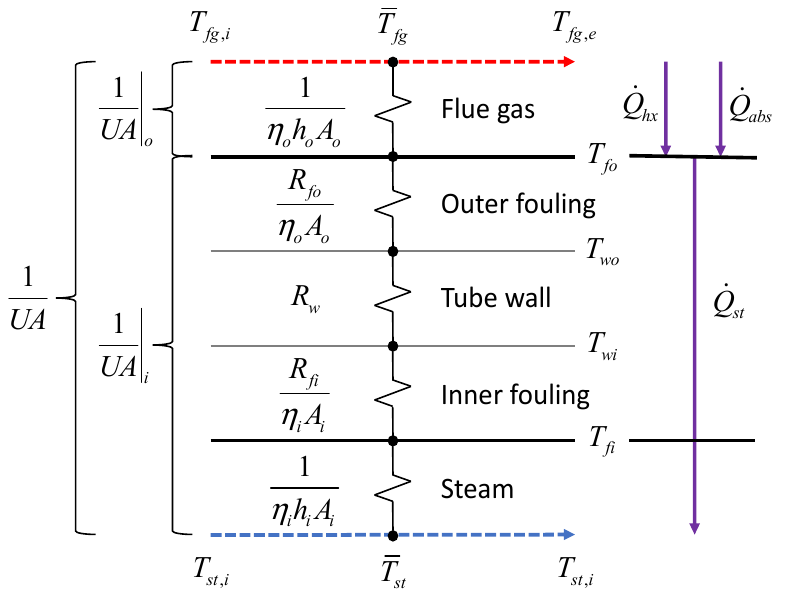
Figure 3. Schematic of a single convective/radiative heat exchanger increment showing the thermal resistances between the flue gas and steam flow paths.